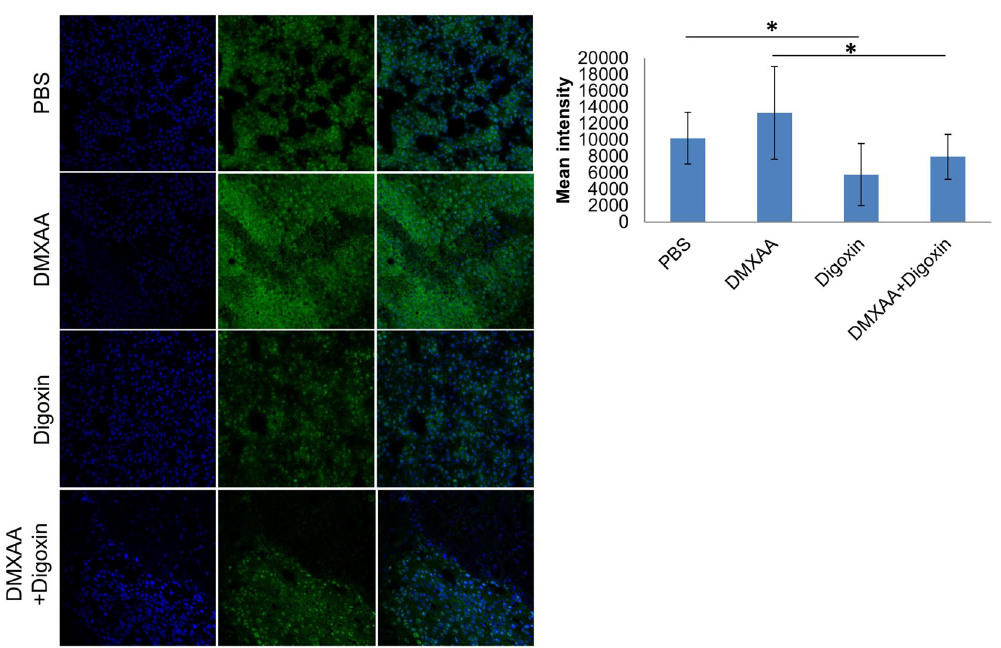
Figure 4. HIF-1 α identification in tumors. The amount of HIF-1 α factor decreased in tumors of mice that received digoxin and combined therapy compared to mice that received PBS and DMXAA (p < 0.05). In the group of mice that received DMXAA, the amount of HIF-1 α increased (no statistical